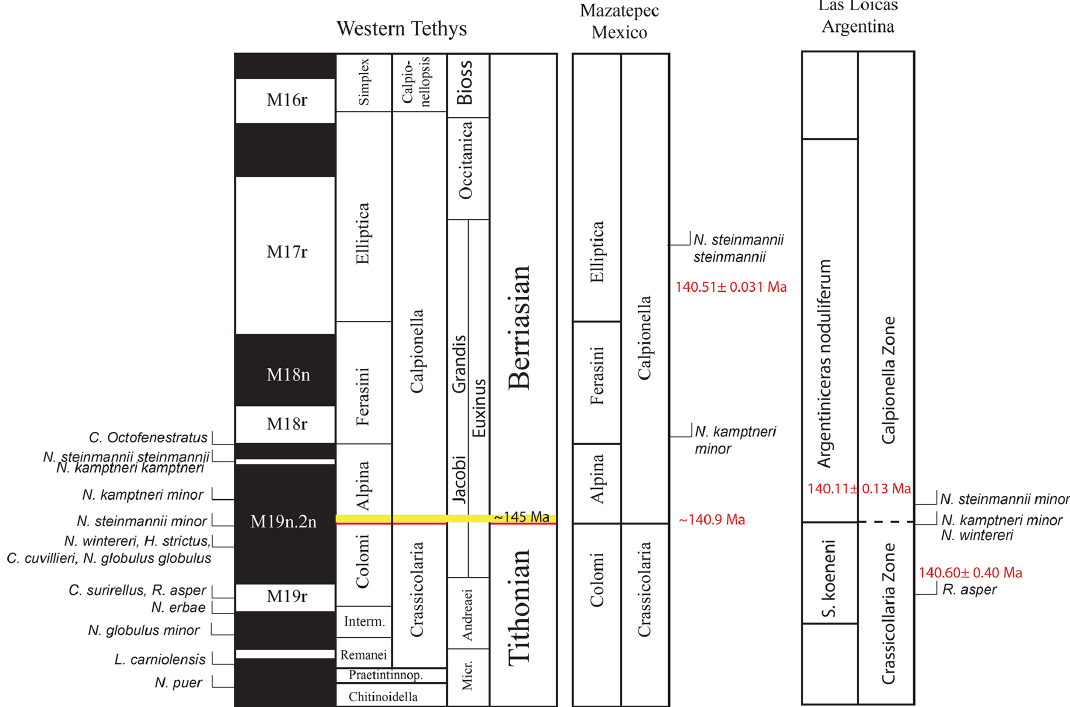
Figure 5. Tentative correlation of the studied sections with the western Tethys correlation scheme of Wimbledon et al. (2017).